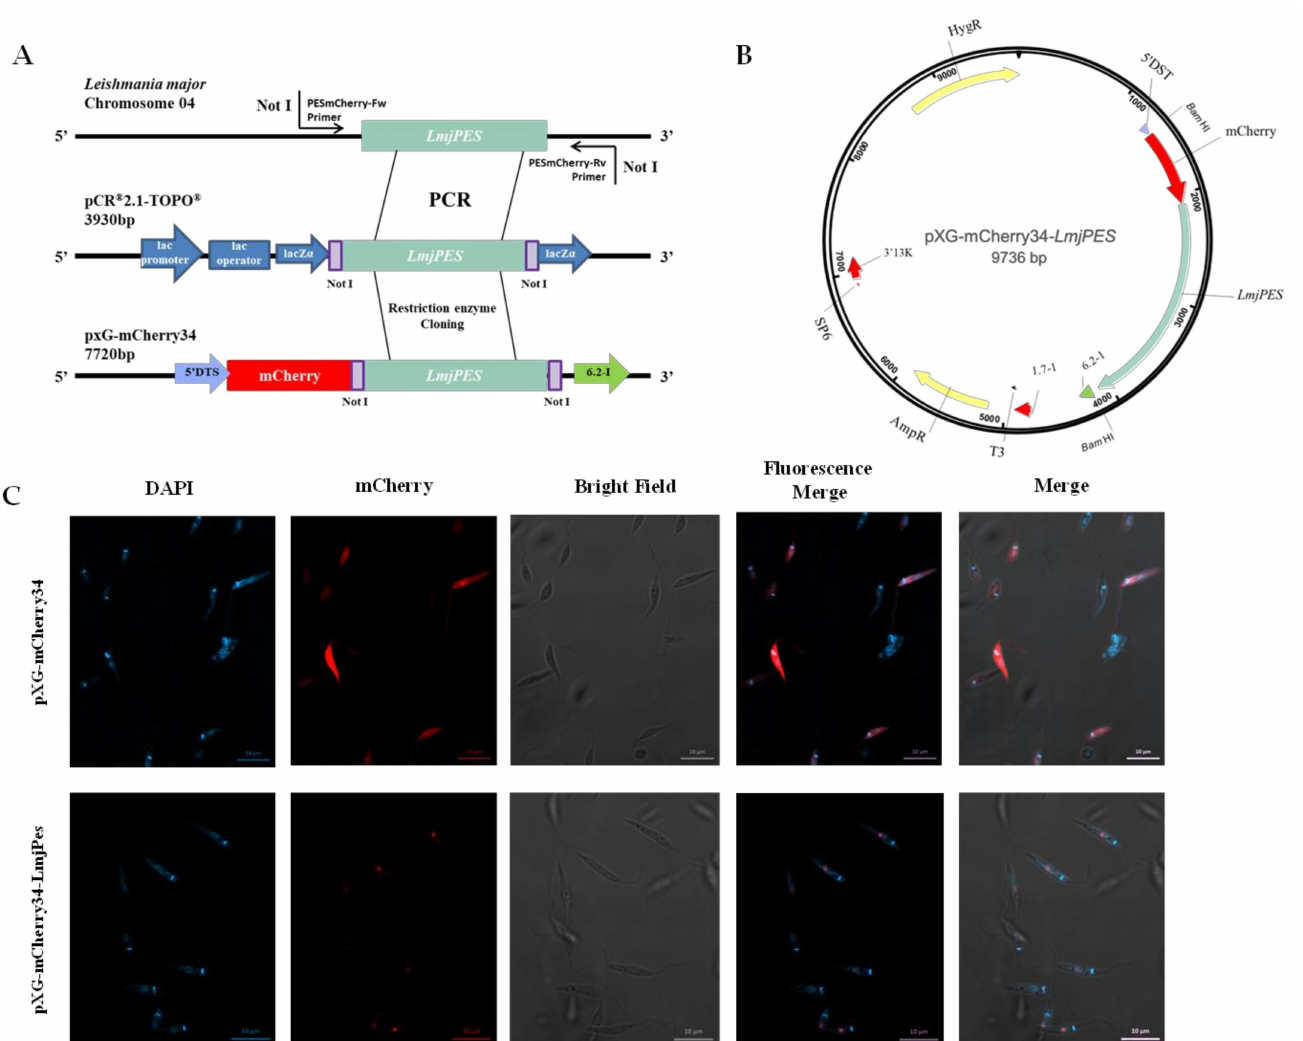
Figure 2. LmjPES is a protein located in the nucleus. ( A ) Schematic representation of the approach to generate the LmjPES red fluorescent protein. ( B ) Map of the plasmid carrying the genetic sequence of the red fluorescent protein mCherry fused to LmjPES gene. ( C ) L. major promastigotes expressing control mCherry34 (top lane) and mCherry34- LmjPES (bottom lane) fusion